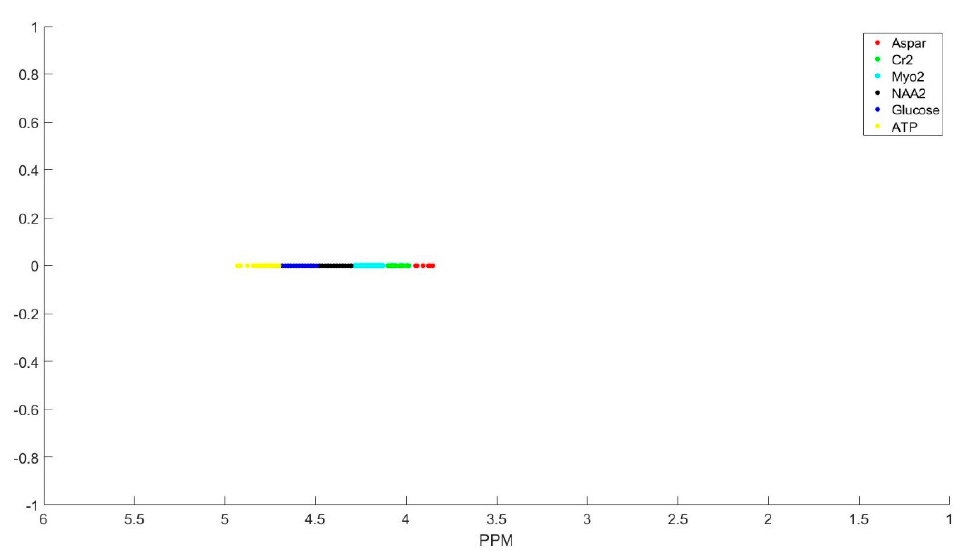
Figure 10. Clustered metabolites basis sets of group 2.